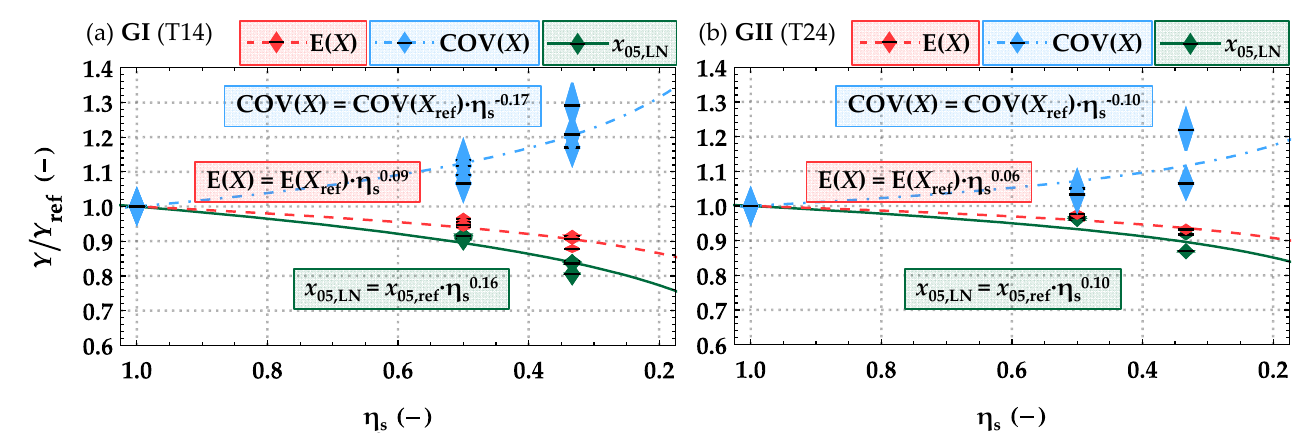
Figure 21. Influence of lengthwise splitting on the main statistics Y = {E( X ); COV( X ); x 05,LN } of the bending strength ( X = f m,g ) of resawn glulam beams relative to the statistics of the bending strength of glulam beams with full cross-section; outcomes for glulam beams built up of virtually generated boards of GI ( a ) and GII ( b ).